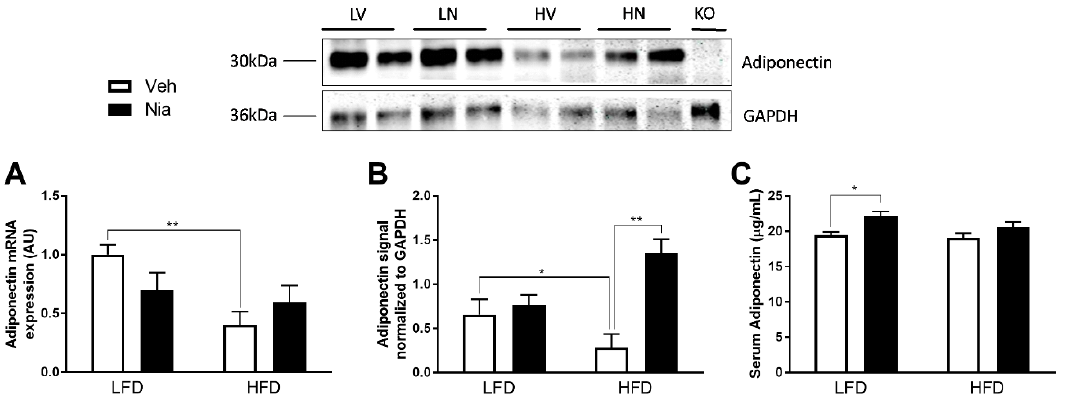
Figure 2. Effects of HFD and niacin on tissue and serum adiponectin concentrations. EWAT adiponectin mRNA expression ( A ), EWAT adiponectin protein expression ( B ), and serum adiponectin concentrations ( C ) in wild-type mice. Adiponectin mRNA values were normalized to Rppl0 expression. Data are presented as mean + SEM. AU: arbitrary units. * p ≤ 0.05; ** p ≤ 0.01; LV: LFD vehicle; LN: LFD niacin; HV: HFD vehicle; HN: HFD niacin; KO: Adipoq -/- . WT LFD Veh, n = 8; WT LFD Nia, n = 8; WT HFD Veh, n = 8; WT HFD Nia, n =7.